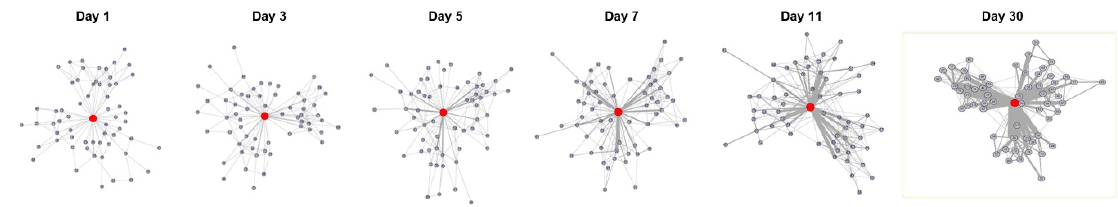
Figure 7. Aggregated view of the network showing the links actually used on a path towards each node over time.